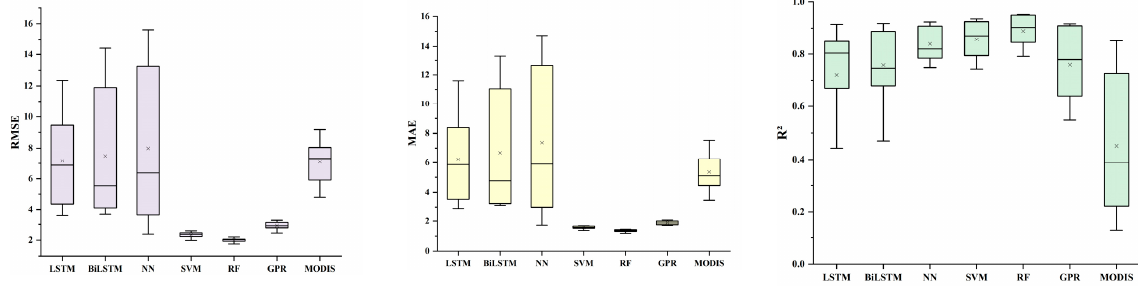
estimation errors with all the three indicators. The RMSE of the LSTM, BiLSTM model and NN model had the highest estimation error with MAE. NN had better results with R 2 .